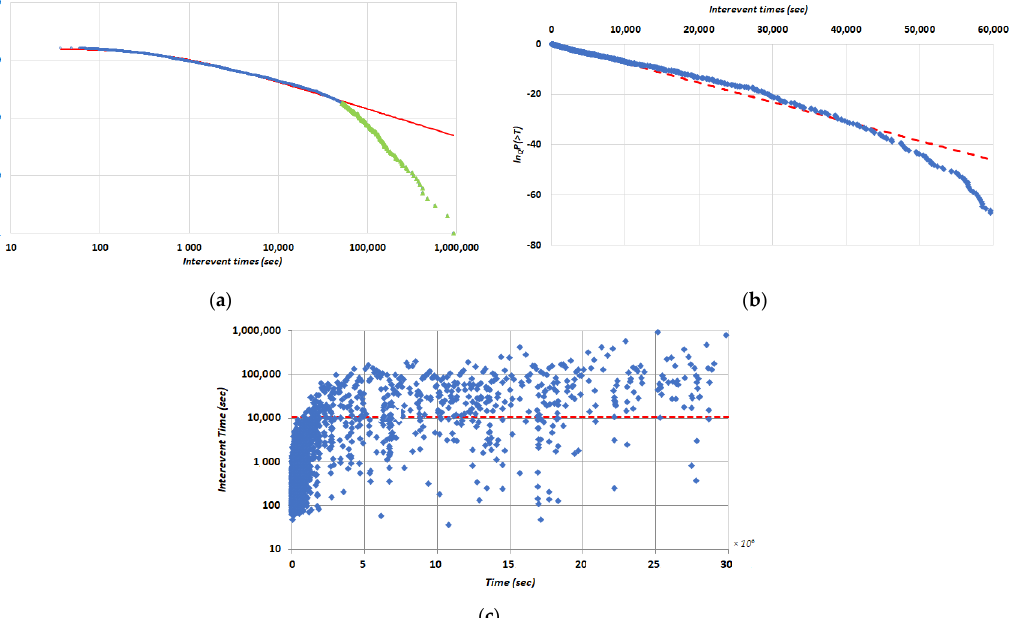
Figure 9. ( a ) The interevent times CDF of the 2017 M w 6.3 Mytilene Earthquake, for the aftershocks with M > M c . The scarlet line is the Q -exponential fitting with q = 1.68. The change of colors indicates the crossover between the NESP (blue circles) and physical BG statistics (green triangles). ( b ) The ln Q P (> T ) as a function of T , where the red line is the fitting with q = 1.68 and correlation coefficient 0.9927 up to T c . T c value close to 10,761 s is suggested by the deviation from linearity. ( c ) Interevent time T evolution with time t since the main shock. The scarlet line illustrates the T c value.